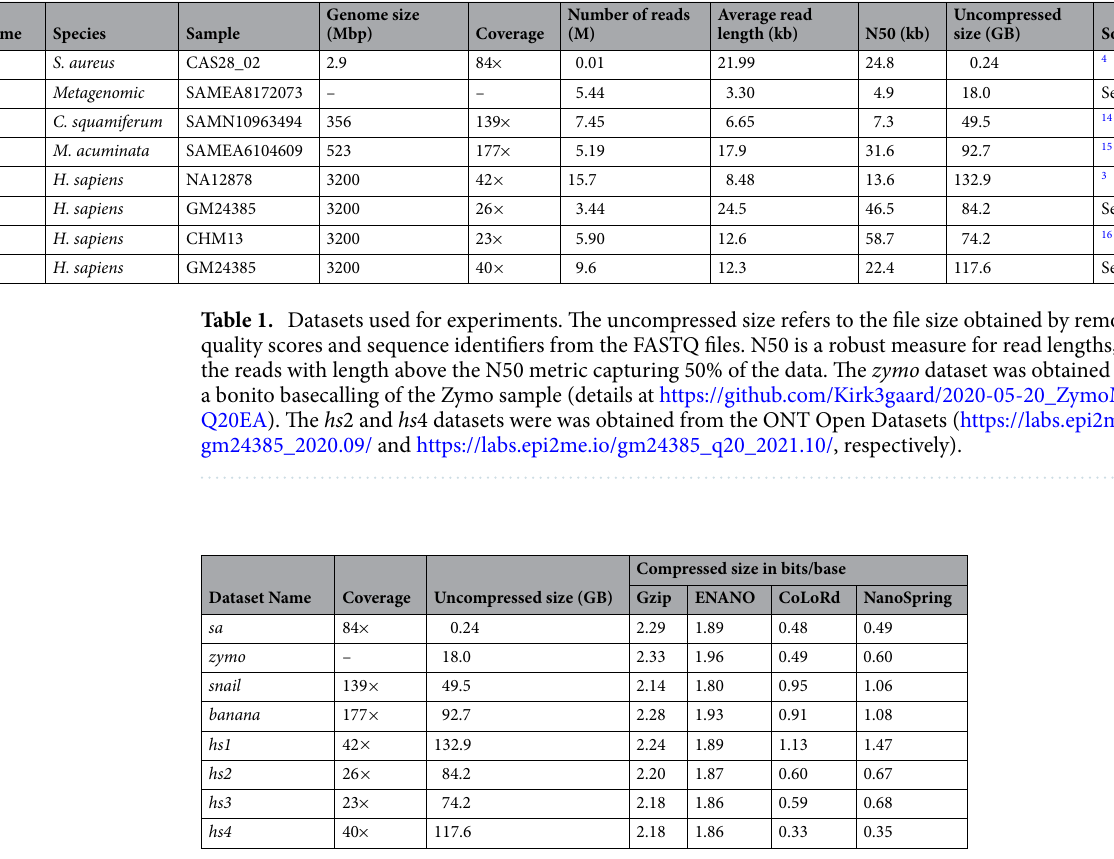
Table 2. Compression results for read sequences using Gzip, ENANO and